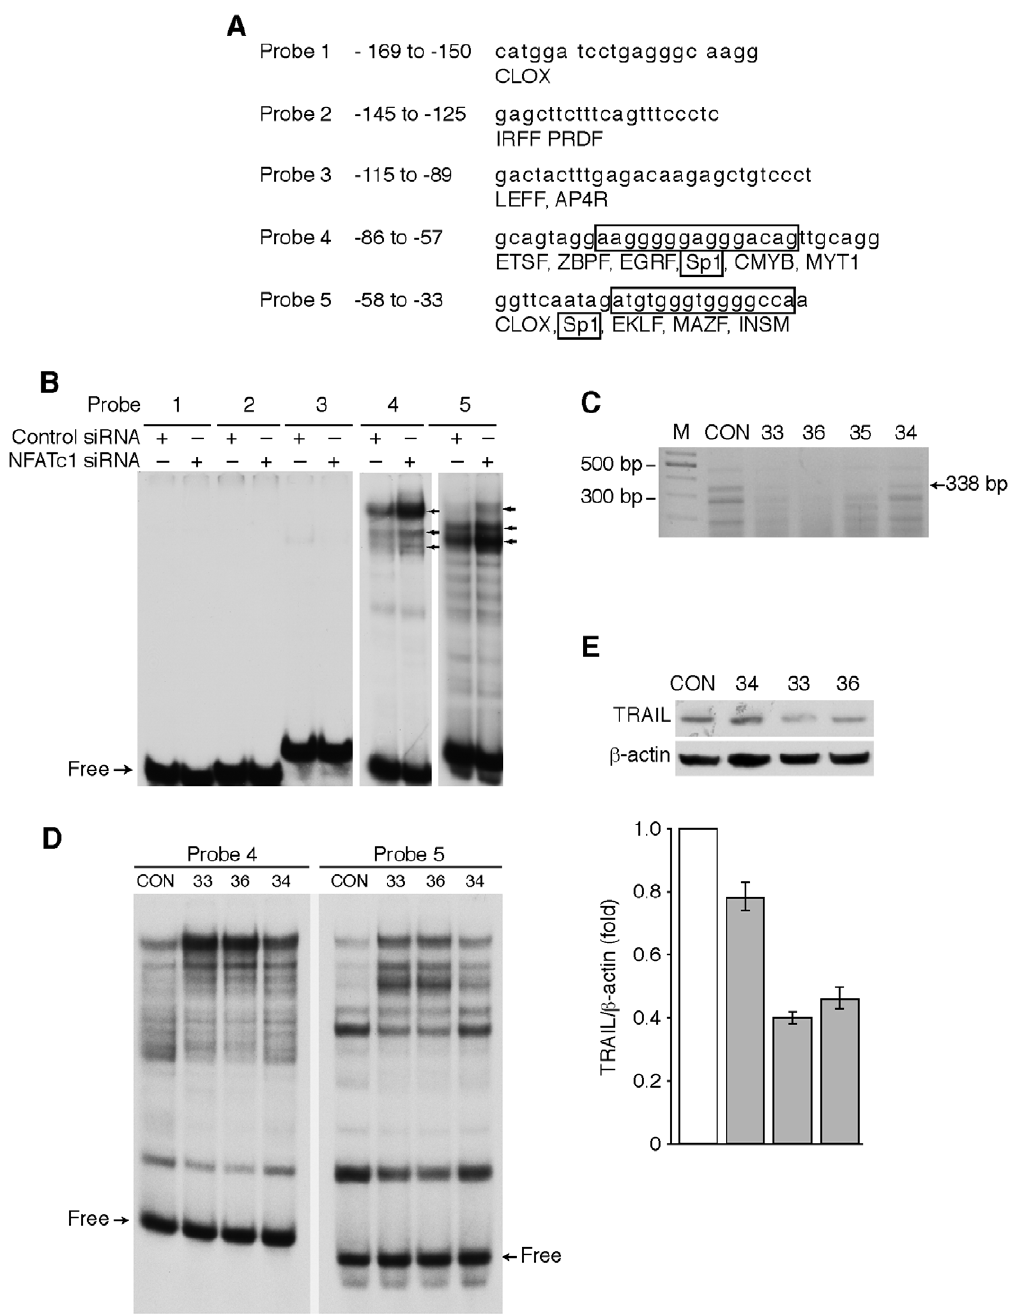
Figure 5. Identification of NFATc1 responsive sequences in the TRAIL promoter. ( A ) Double-stranded oligonucleotides corresponding to all of the potential transcriptional binding sites in human TRAIL promoter 2 169 to 2 33 were synthesized and used for DNA binding analysis. The putative Sp1 binding sequences are boxed, which are also overlapped with other transcription factor binding sequences. ( B ) HT29 cells were treated with or without PMA/Io for 60 min and nuclear protein extracted. Double-stranded oligonucleotides (as shown in A) were radiolabeled and tested for DNA binding by EMSA. The arrows indicated the increased binding complexes. ( C ) Total RNA from HT29 cells stably transfected with control (CON) or four individual shRNAs targeting human NFATc1 (clones 33, 34, 35, 36) was extracted and RT-PCR performed for NFATc1 mRNA expression. ( D and E ) Nuclear protein (D) or total protein (E) from HT29 cells stably transfected with control (CON) or NFATc1 shRNA (clones 33, 34, 36) was extracted. EMSA was performed (D) using probe 4 and probe 5 (sequences shown in Figure 6). Western blotting was performed for the analysis of TRAIL expression (E); membranes were stripped and re-probed with anti- b -actin to confirm equal loading. TRAIL signals from two separate experiments were quantitated densitometrically and expressed as fold-change with respect to b -actin (Data shown as mean 6 standard error of the mean).